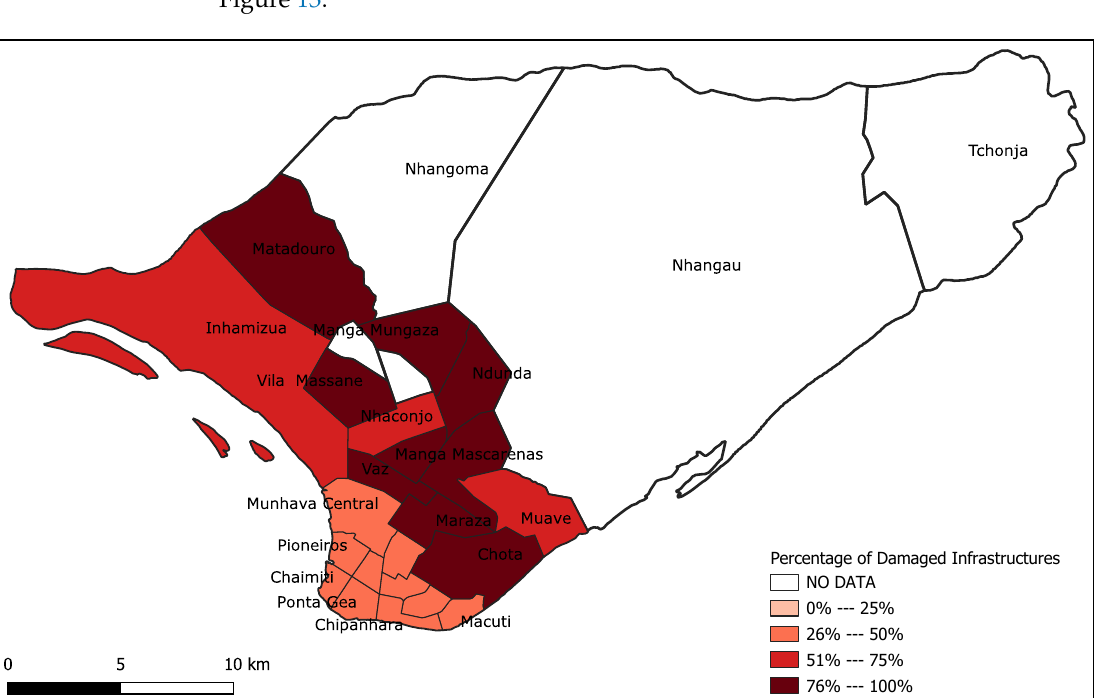
Figure 12. Aggregated inflow, remain and outflow from each neighborhood. From Figure 12, it is clear that overall the number of people who remained in each neighborhood was less than the inflow (number of arrival in the neighborhood) and outflow (number of people who left the neighbor after the disaster). However, inflow and outflow vary from one neighborhood to another; i.e., in some cases, the inflow is greater than outflow (e.g., Ponta Gea, Alto data Manga, etc.), and in other cases, the inflow is less than outflow (e.g., Vaz, Esturo, Matacuane, etc.). These differences are supported by the idea that some neighborhoods were more highly affected than others REACH [42], as shown in Figure 13.